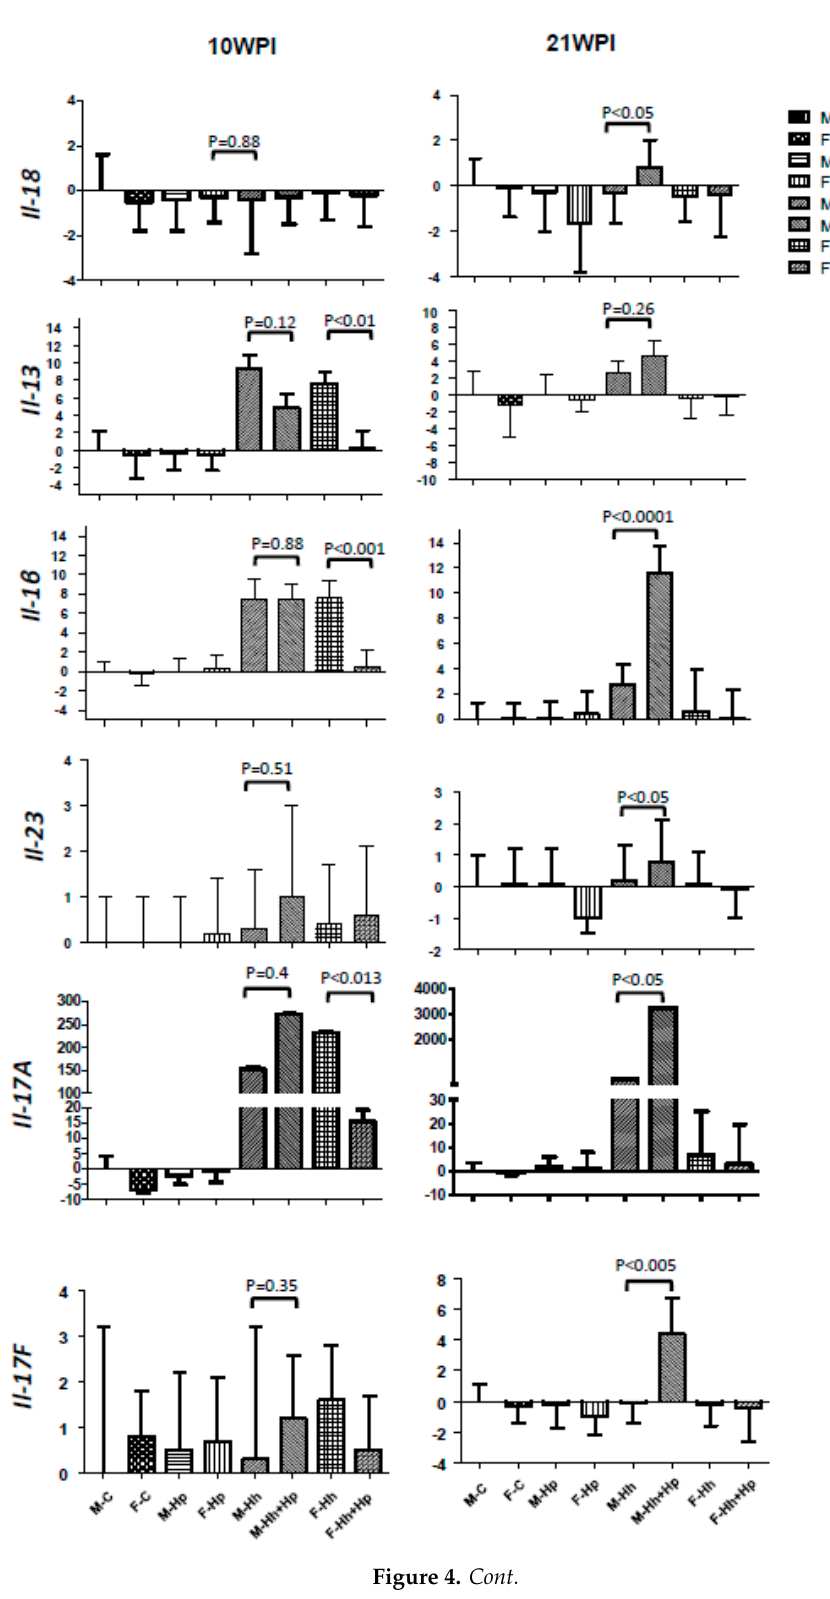
mRNA levels of cecal Il-10 in mono-Hh females compared to the sham females at both time-points (Figure S5, p < 0.04). Int. J. Mol. Sci. 2020 , 21 , x FOR PEER